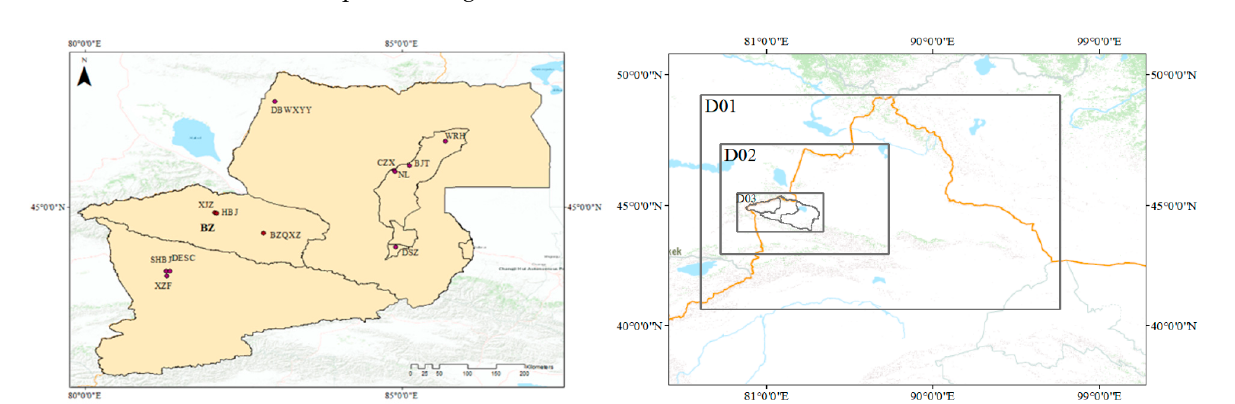
Figure 1. National environmental quality monitoring stations, weather stations and modeling do- mains.